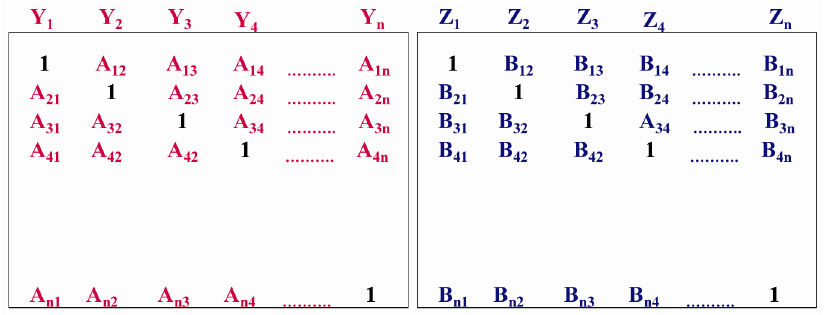
Fig. 2. Incidence matrixes in